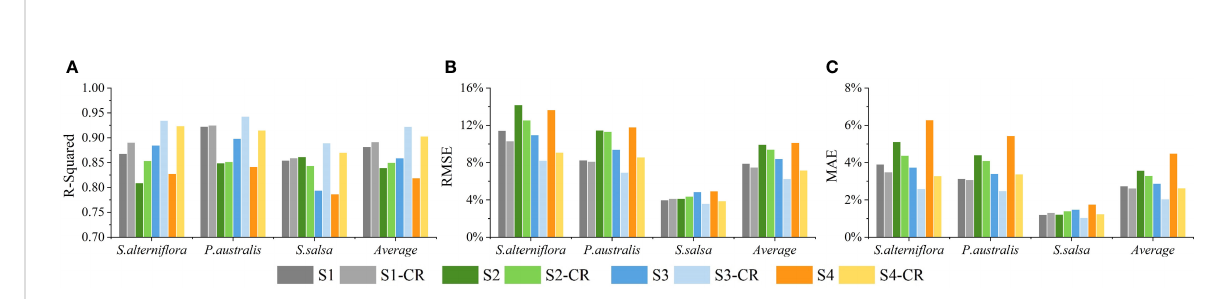
FIGURE 7 (A) R-square, (B) RMSE and (C) MAE of the fractional cover estimation of different salt marsh vegetation species from four scenarios using Ensemble Learning model. S1~S4: Scenario 1 ~ Scenario 4 based on the original Landsat imagery; S1-CR ~ S4-CR: Scenario 1 ~ Scenario 4 based on the cloud-removed Landsat imagery.